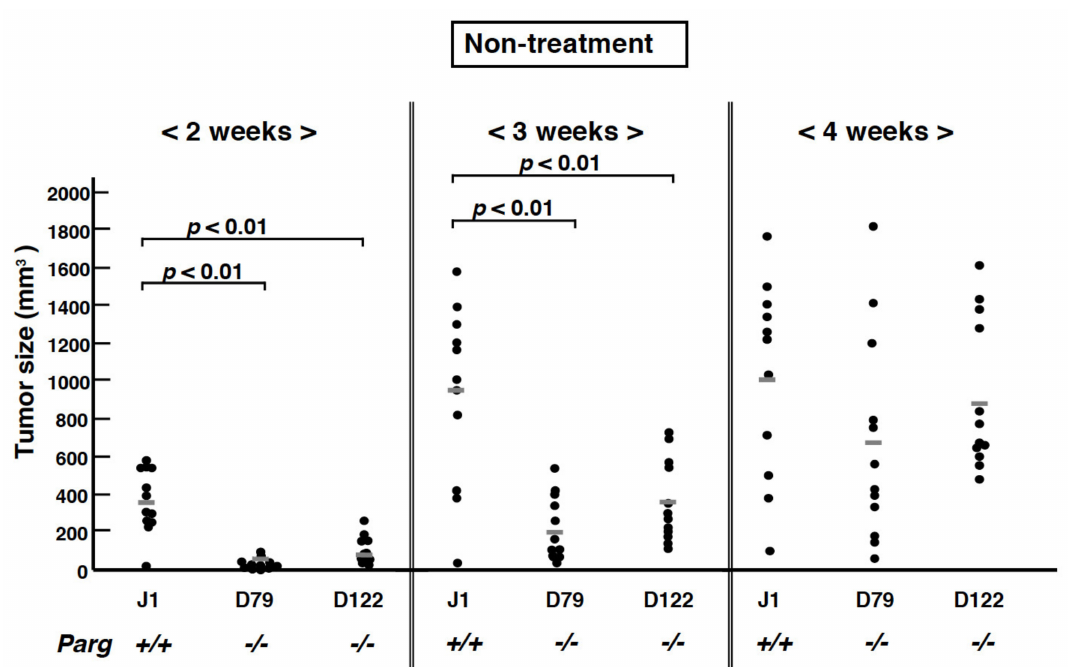
Figure 1. E ff ect of Parg deficiency on tumorigenesis from embryonic stem (ES) cells. In total, 1 × 10 7 ES cells were inoculated s.c. into nude mice and size of tumors was measured weekly. Wild-type, J1. Parg − / − , D79 and D122.